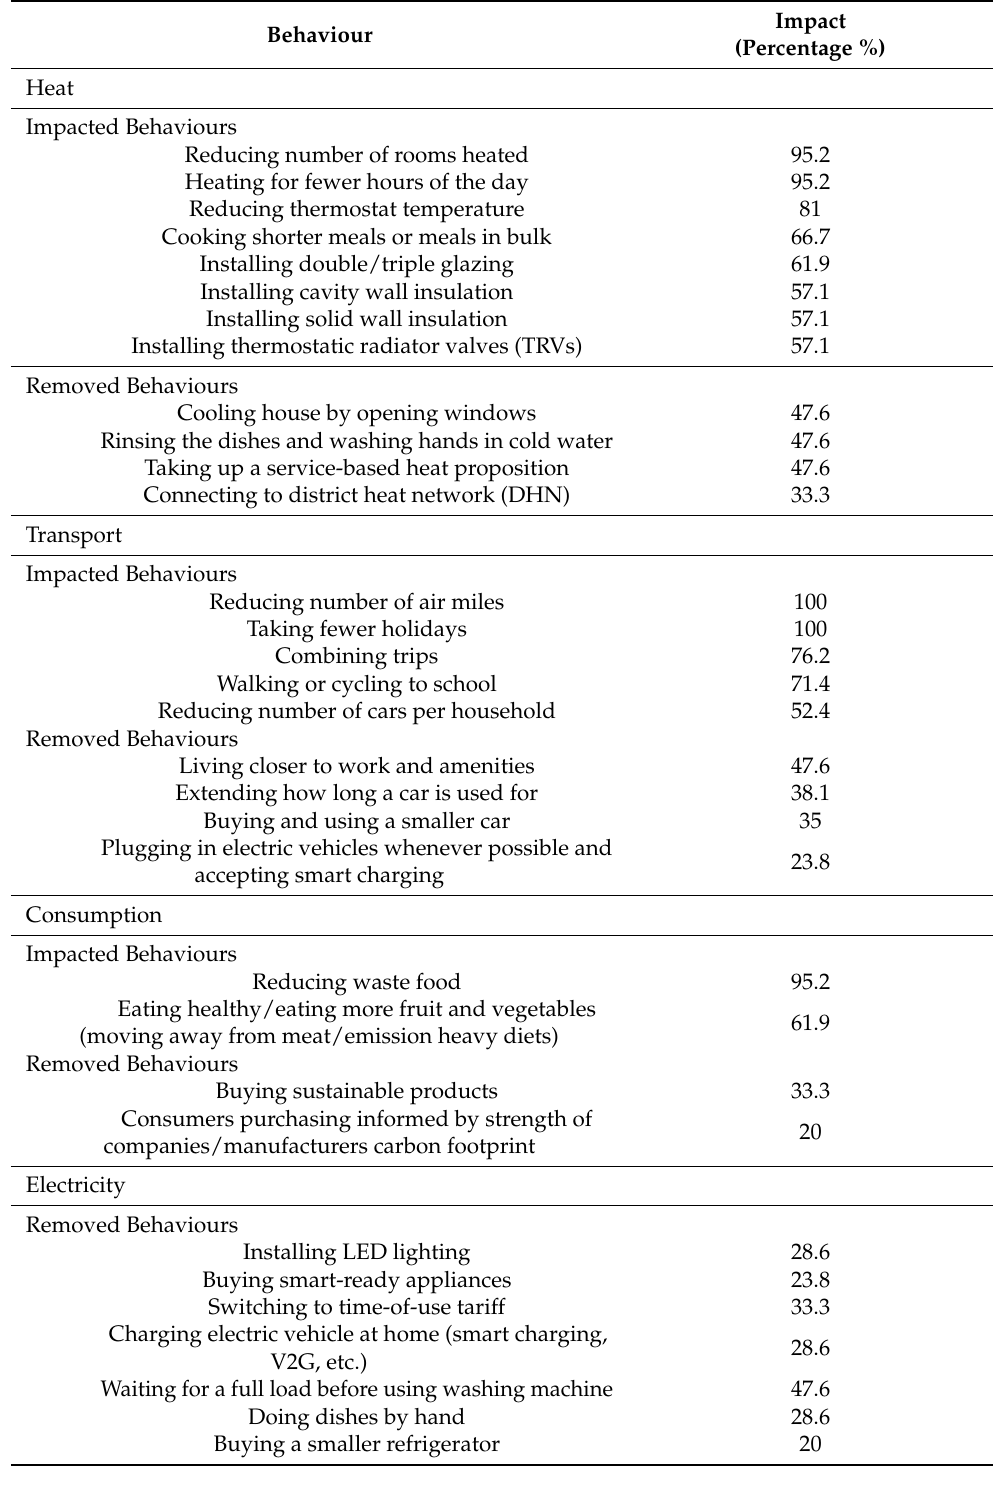
Table 1. Climate change mitigation behaviours identified as ‘impacted’ by COVID-19 in Round 1 (over 50% of experts indicated behaviour has been impacted), behaviours removed/not progressed to Round 2 (below 50% of experts indicated behaviour has been impacted by COVID-19) and percentage value of panellists that indicated respective behaviours were impacted by